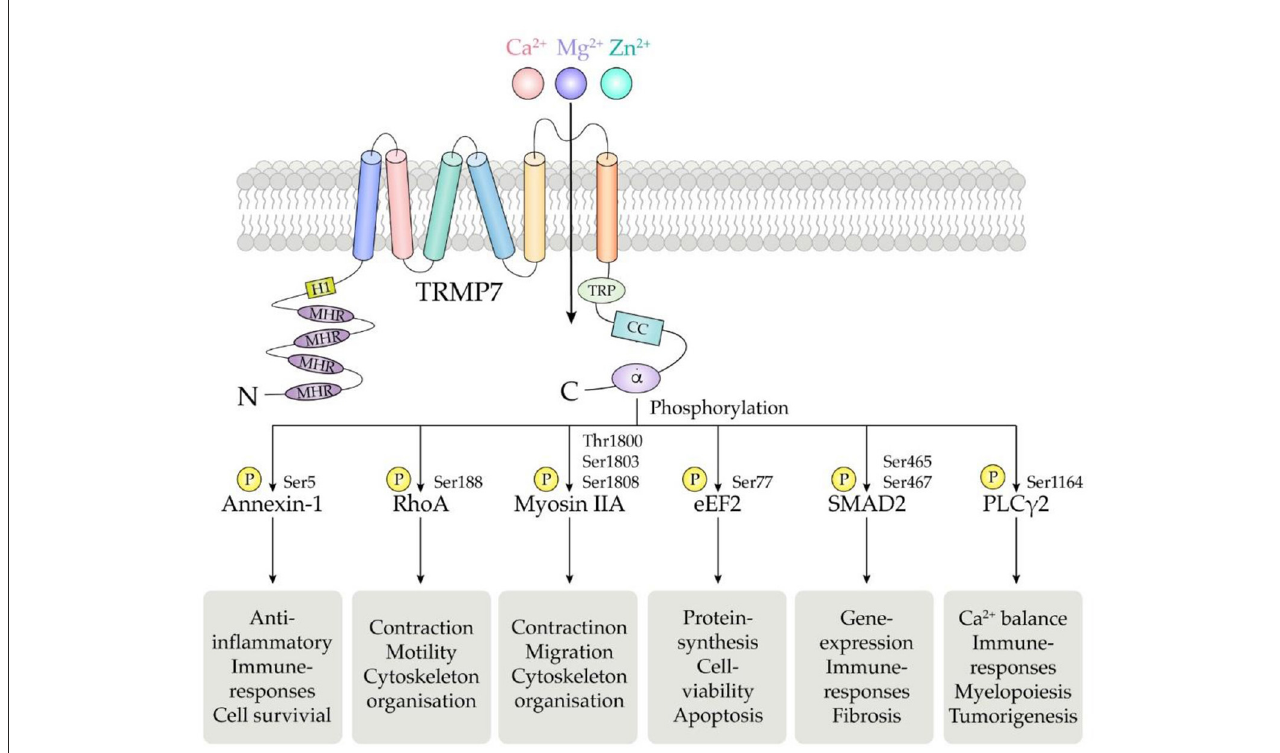
FIGURE2 Schematic structure of the TRPM7 chanzyme. It consists of six transmembrane segments with the channel pore formed between segment 5 and 6. TRPM7 channel is permeable to divalent cations including Mg 2 + , Ca 2 + , and Zn 2 + .The α -kinase domain is able to phosphorylate diverse downstream substrates such as annexin-1, RhoA, myosin IIA, eEF2, SMAD2, and PLC γ 2, at specific phosphorylation